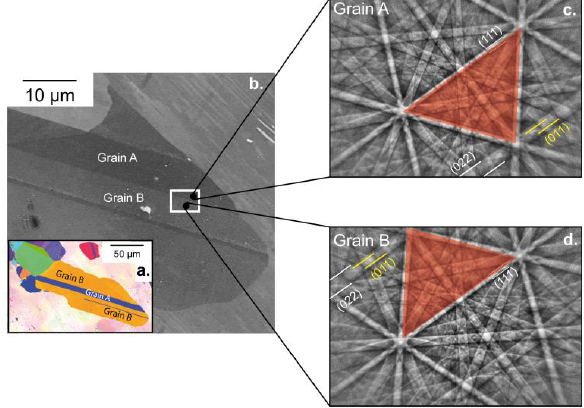
Figure 1. ( a ) Electron backscattered diffraction (EBSD) orientation map of the zone of interest. ( b ) Enhanced BSE image showing the microstructure before deformation. The nanoindentation array is localized in the white rectangle. ( c , d ) EBSD patterns corresponding to grains A and B.